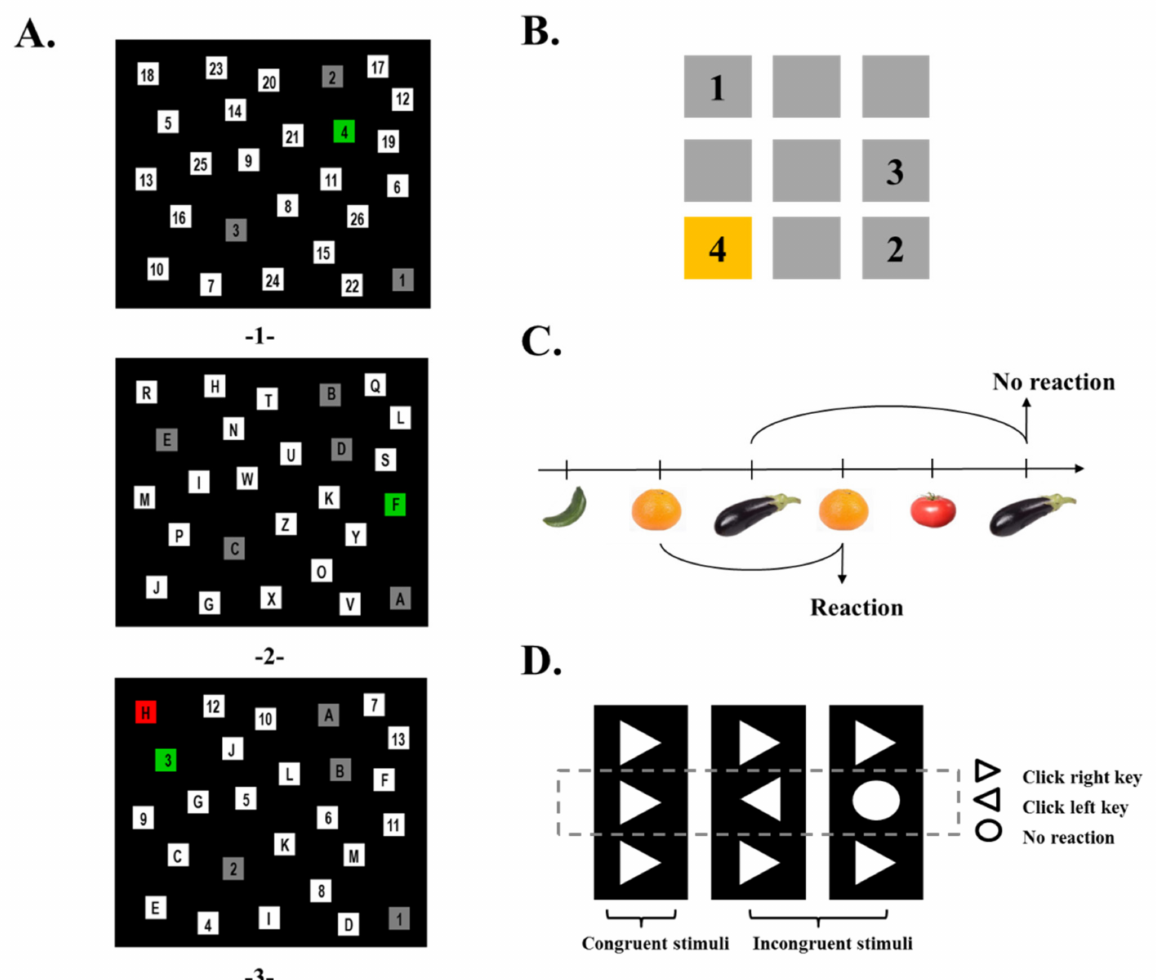
Figure 2. Cognitive task. ( A ). Visual attention and switching abilities between two targets: numbers and letters, measured by task switching . The task is comprised of three sections. 1. First section, numbers (non-switch). Numbers had to be clicked in ascending order with the mouse cursor. 2. Second section, letters (non-switch). Letters from A to Z had to be clicked alphabetically. 3. Third section, consecutively switching between numbers and letters in ascending order (i.e., 1-A-2-B-3-C . . . 13-M). The target turned red if the answer was incorrect or green if the answer was correct. ( B ). Visual-spatial memory measured by the Corsi block-tapping task . Nine blue squares appearing as stimuli on the screen changed the color in a spatial random order. Three to six block sequences were displayed and had to be repeated in the same order. ( C ). Working memory updating measured by a 2-back task . Fruits and vegetables were displayed on a computer screen. A predefined key had to be pressed when the current image was the same as the image two trials back. ( D ). Inhibitory control measured by flanker task . Directional response to the stimuli: congruent flankers and incongruent flankers were needed by pressing a defined computer